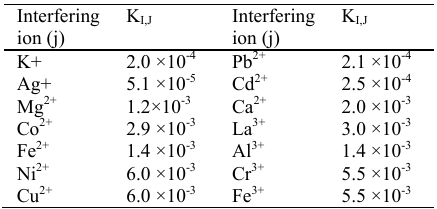
Table 2. Selectivity coefficients of various interfering ions for the Hg(II) sensor, calculated by two solutions method. Interfering ion (j)